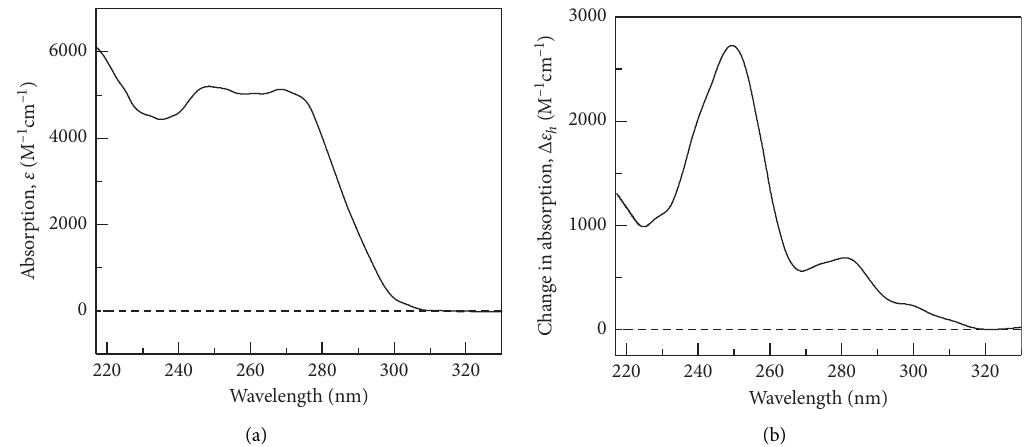
Figure 2: (a) Absorption spectrum of poly(I:C) polynucleotide and (b) its change induced by the heating from 20 ° S to 92 ° S